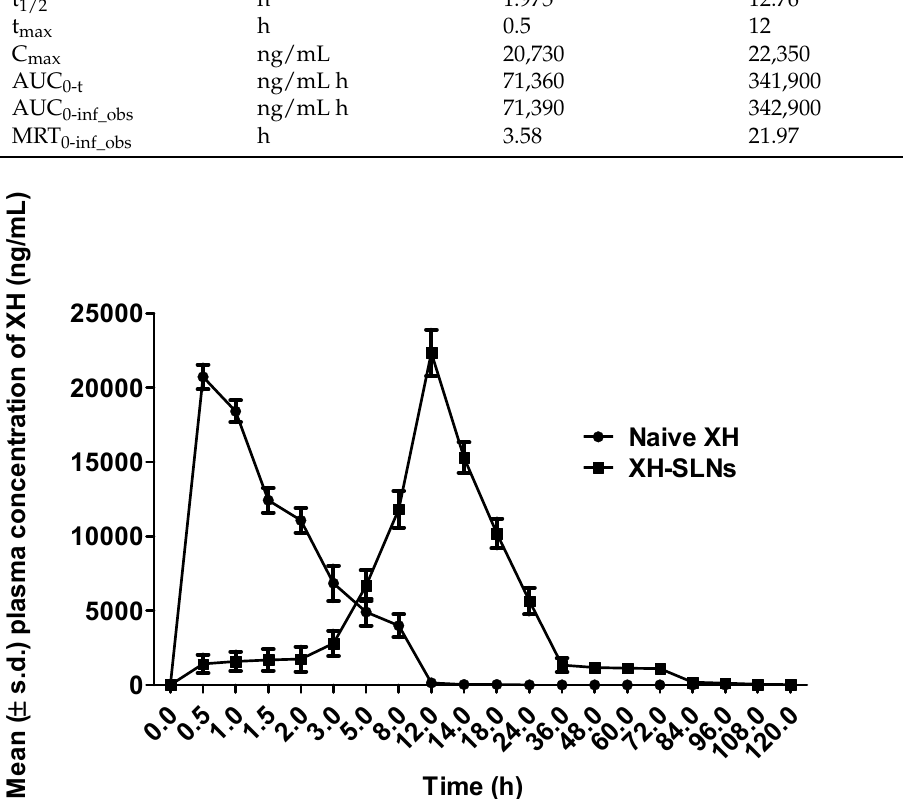
Figure 11. Plasma drug concentration-time profile of naive XH and XH-SLNs. Table 7. Representing the pharmacokinetic data of XH and XH-SLNs.